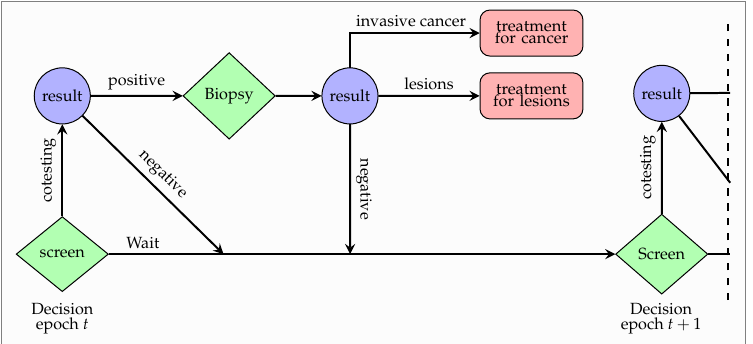
Figure 2. Timeline of the decision